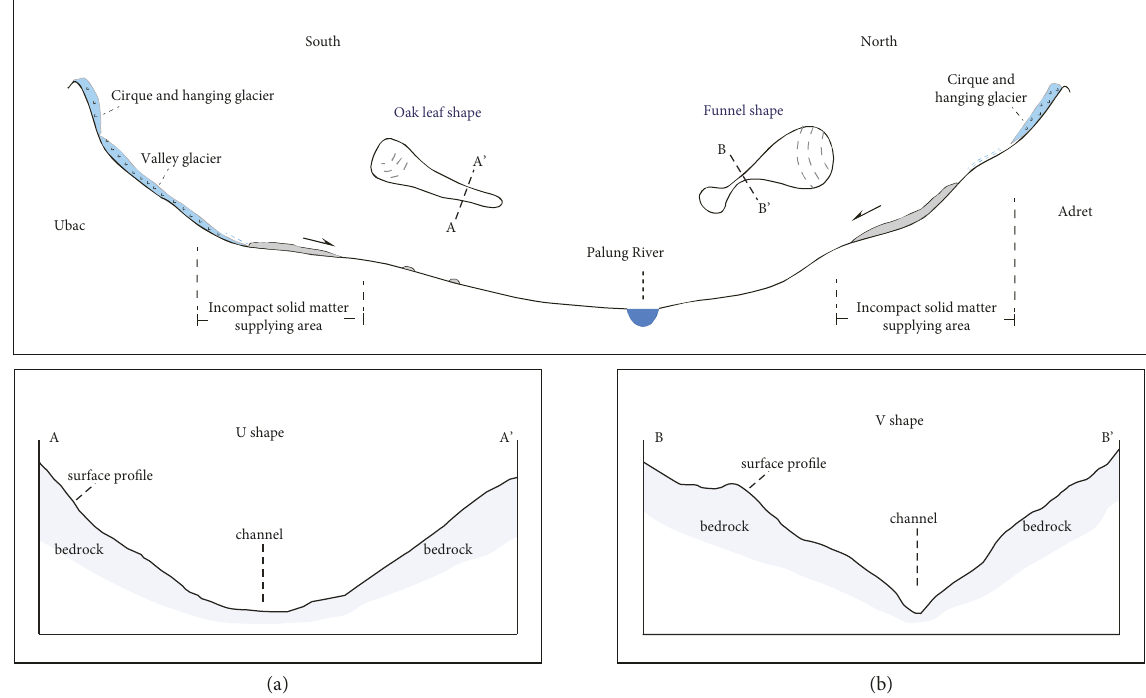
Figure 5: The generalized model to describe the comparison of gully geography along the two banks ((a) cross section of most gullies in the south bank; (b) cross section of most gullies in the north